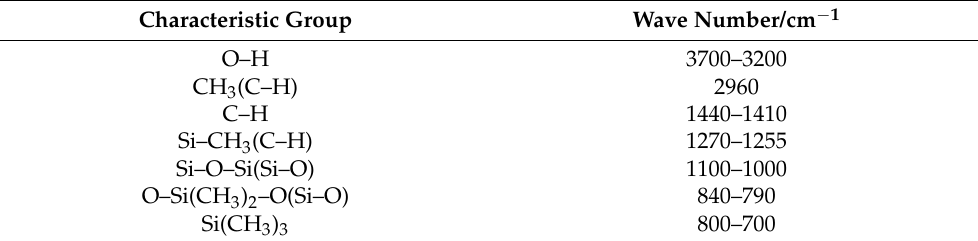
Table 3. Characteristic peaks of silicon rubber in IR